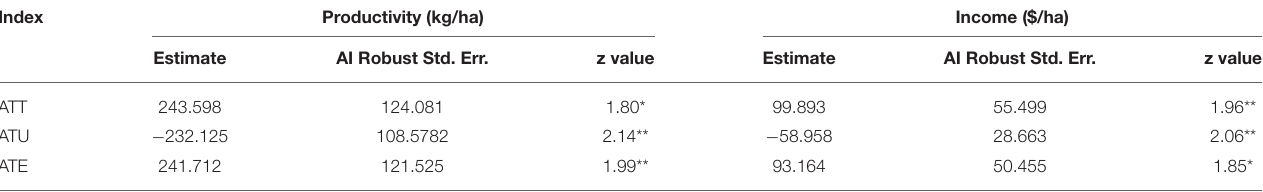
TABLE 4 | Average treatment effect of adoption on productivity and household